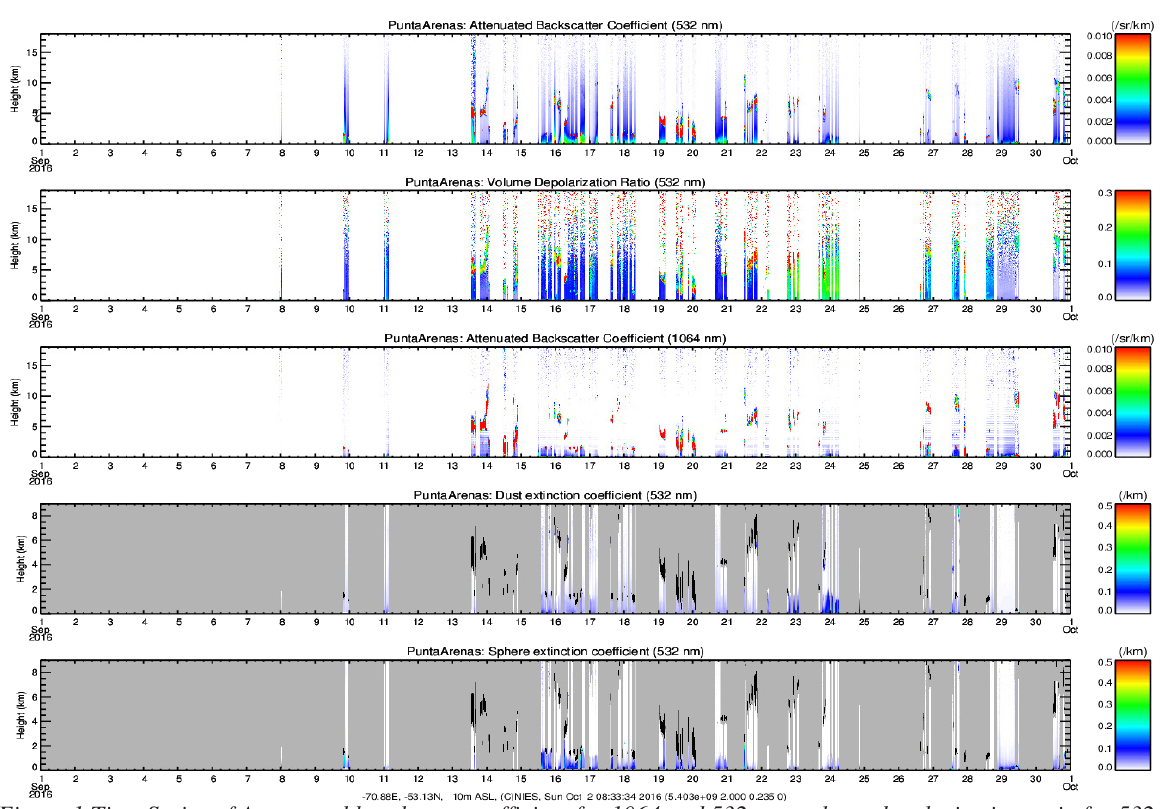
Figure 1 Time Series of Attenuated bacskatter coefficient for 1064 and 532 nm, volume depolarization ratio for 532 nm and dust and spherical extinction coefficient at 532 nm (first, second, third and fourth panel respectively), during the month of 2016.